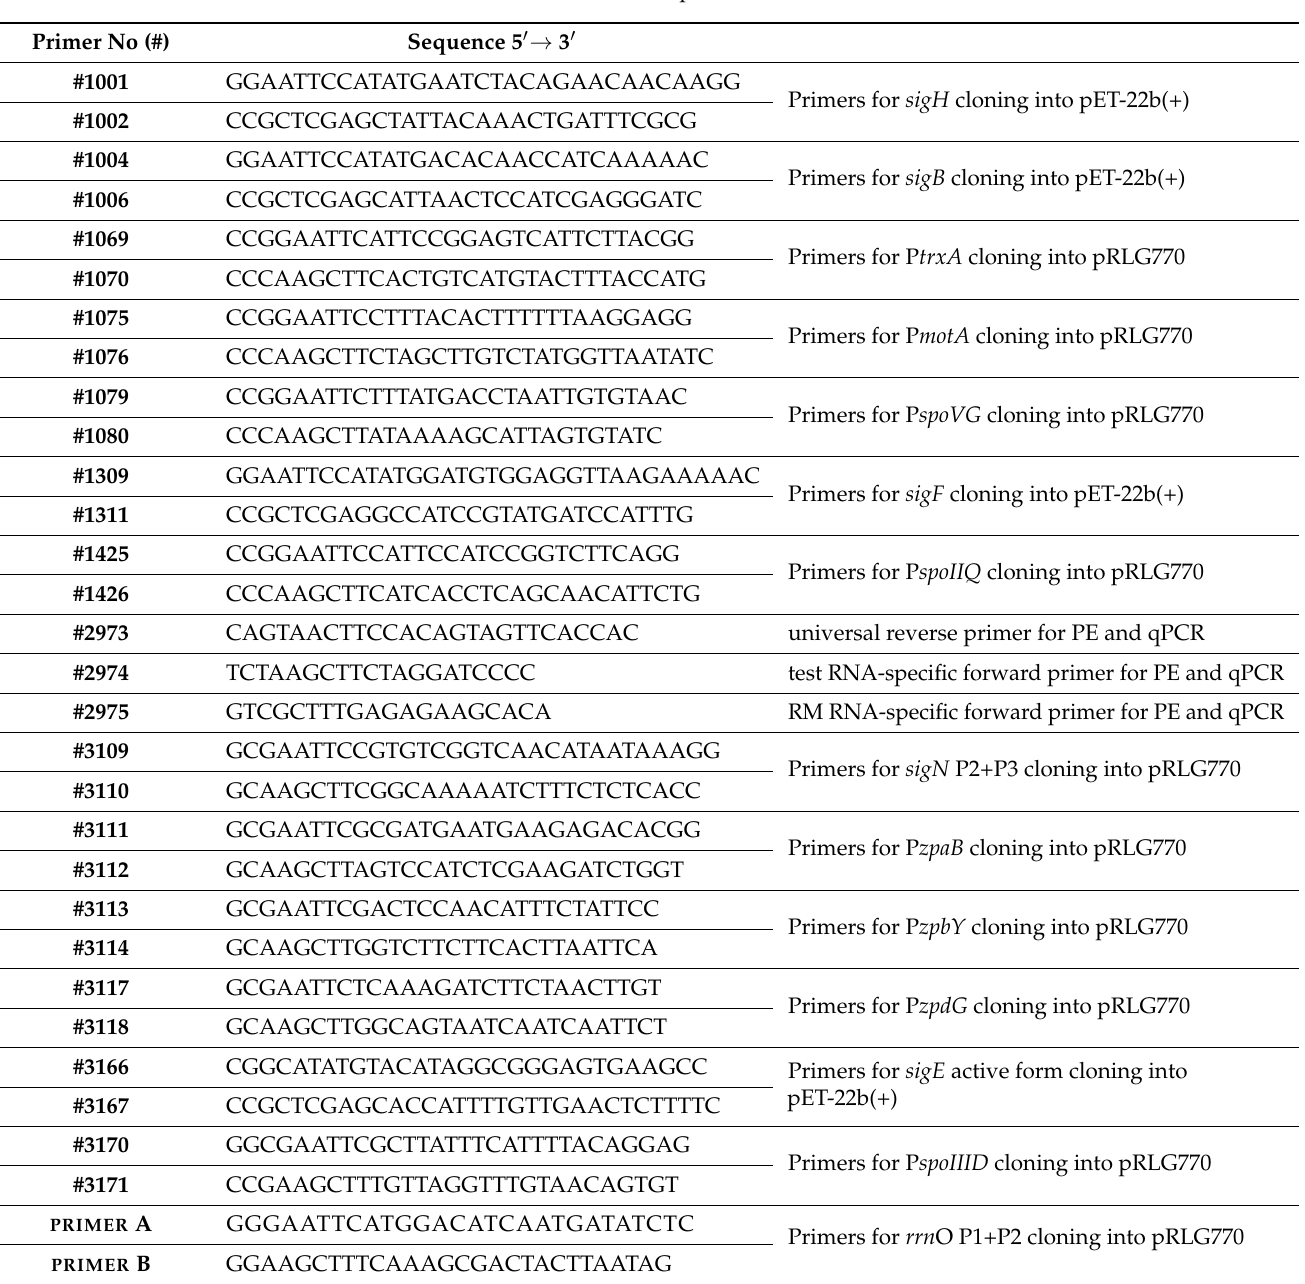
Table 2. List of